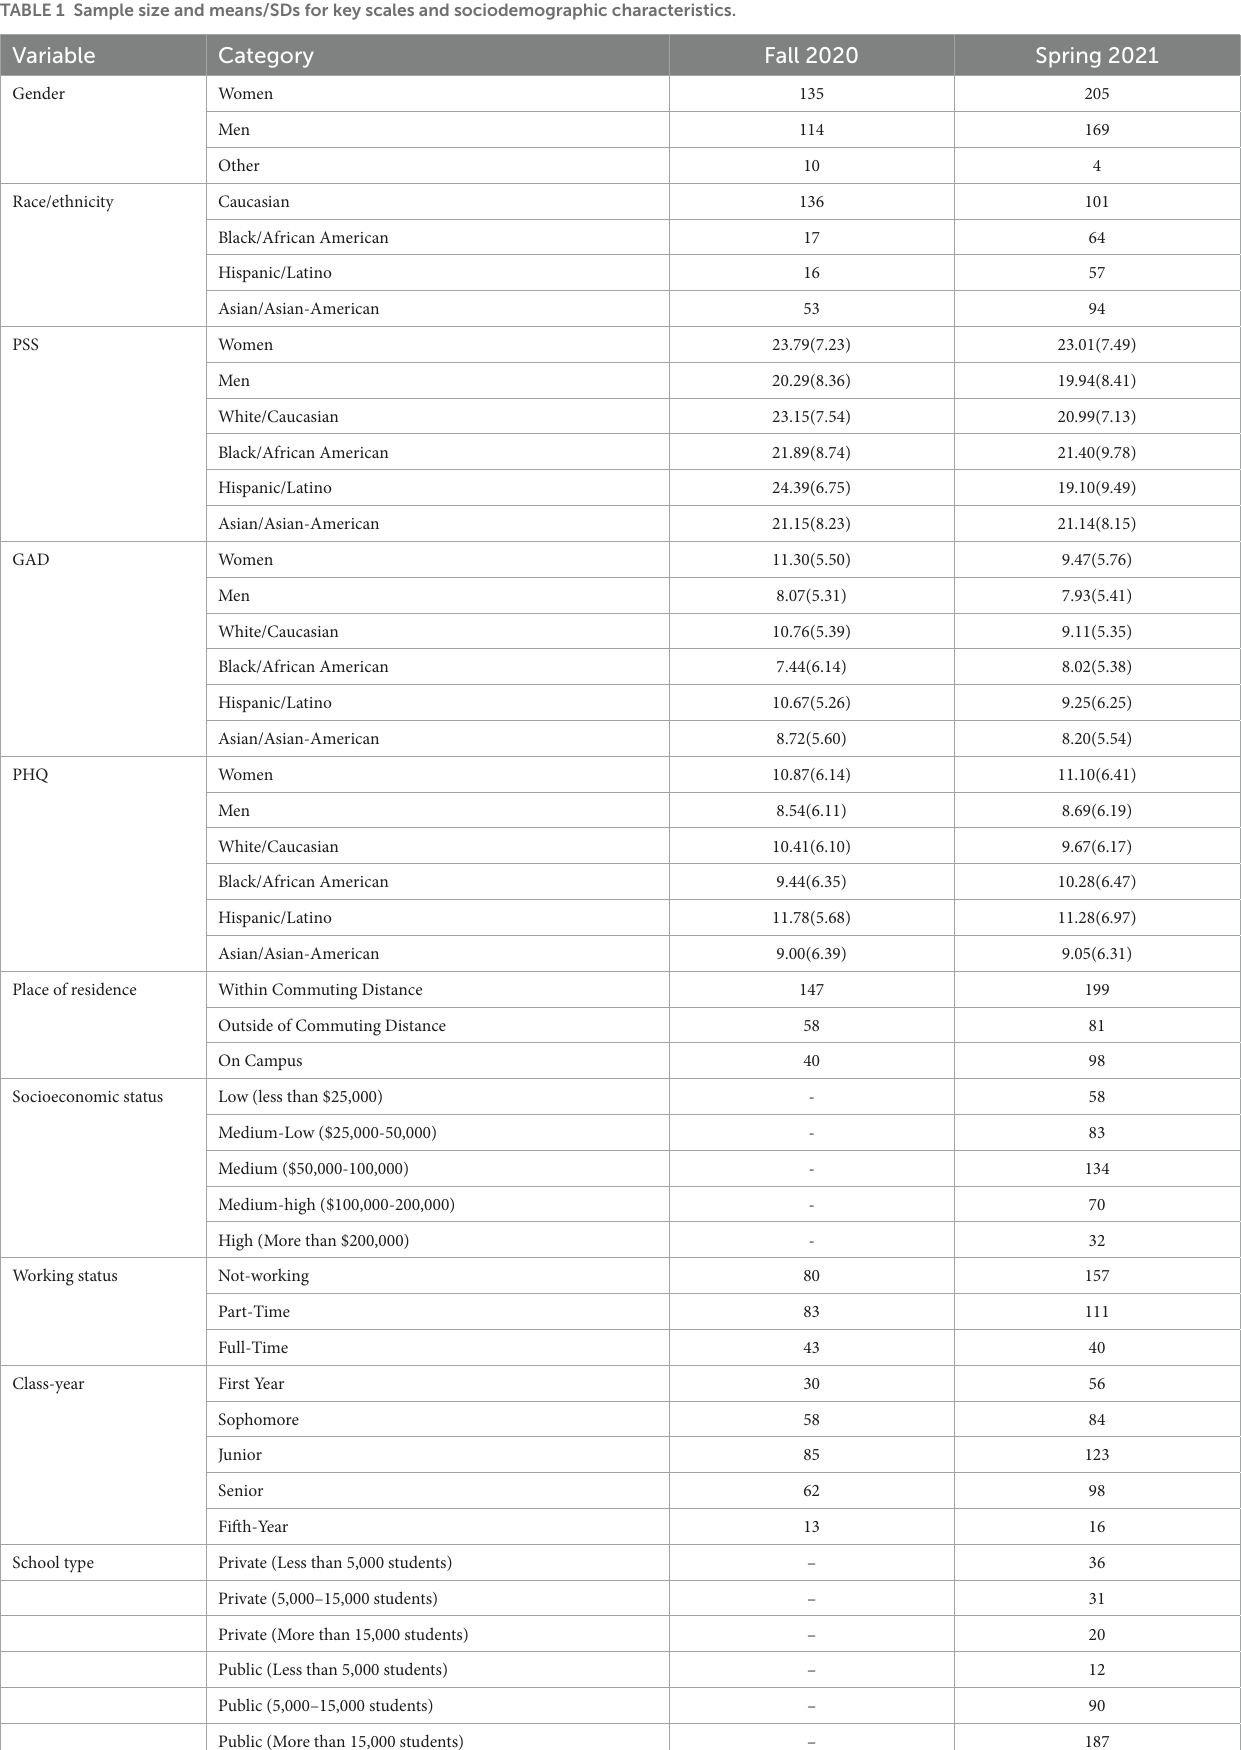
TABLE 1 Sample size and means/SDs for key scales and sociodemographic characteristics. Variable